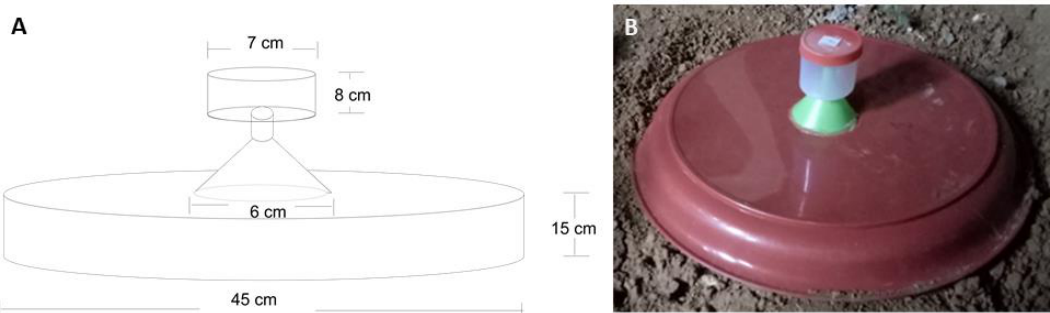
Figure 2. Modified emergence trap to determine potential breeding sites. ( A ) The schematic design of the modified emergence trap consisted of a tray, a plastic funnel, and a closed transparent container on top. ( B ) The modified emergence trap used in this study. They were placed to cover suspected breeding sites.